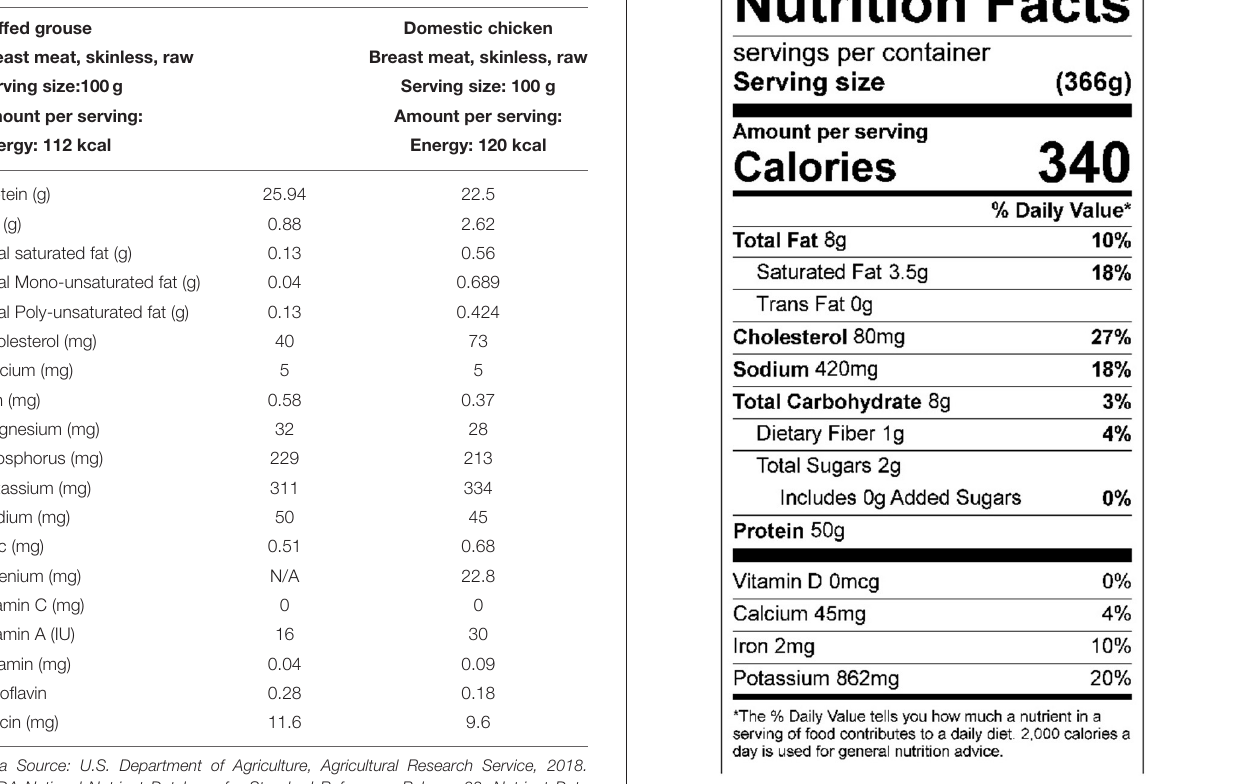
FIGURE 2 | Braised Ruffed Grouse white nutrition fact label. Source: www.wildharvesttable.com.